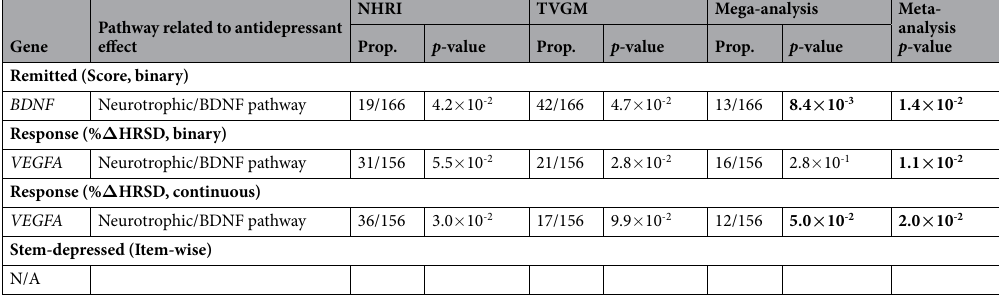
Table 4. BDNF -related susceptibility genes for major depressive disorder that related to response to antidepressant drug treatment in Han Chinese Abbreviation: Prop, proportion of significant SNPs. a Gene-based association analyses were based on 421 major depressive disorder patients. b Only genes that reached p -value at the level of 0.01 (or 0.05) either in mega-analysis or in meta-analysis were reported as significant (or suggestive) loci, based on 50,000 permutations. c Models were adjusted for gender and age. d Proportion of significant SNPs was defined as the number of significant SNPs ( p -value < 0.05) divided by total number of SNPs in that gene. e We conducted linear (if continuous) and logistic (if dichotomous) regressions analyses for treatment-response phenotypes.